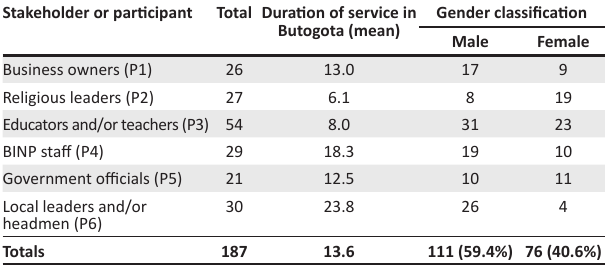
TABLE 1: Key stakeholders for the study.